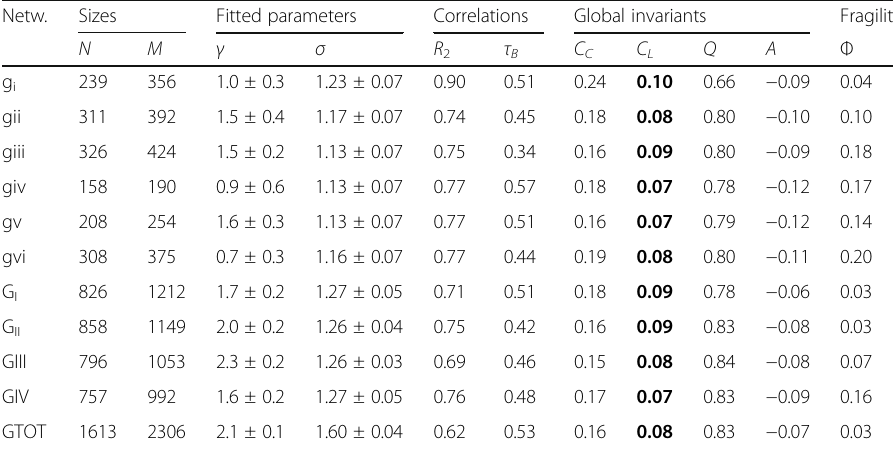
Table 2 Characteristics of networks g X corresponding to distinct periods X = i ,..., vi and G X of aggregated periods X = I ,..., IV Netw . Sizes Fitted parameters